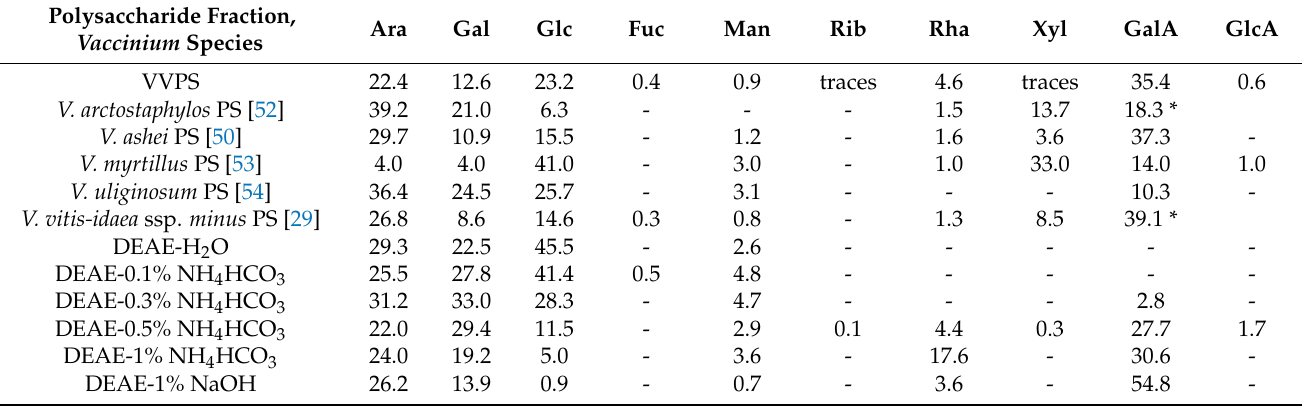
Table 3. Monosaccharide composition of VVPS, DEAE–cellulose fractions and Vaccinium fruits polysaccharides (PS),